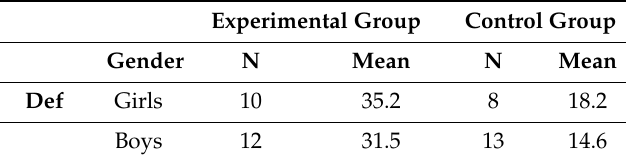
Table 9. Performance statistics per gender.